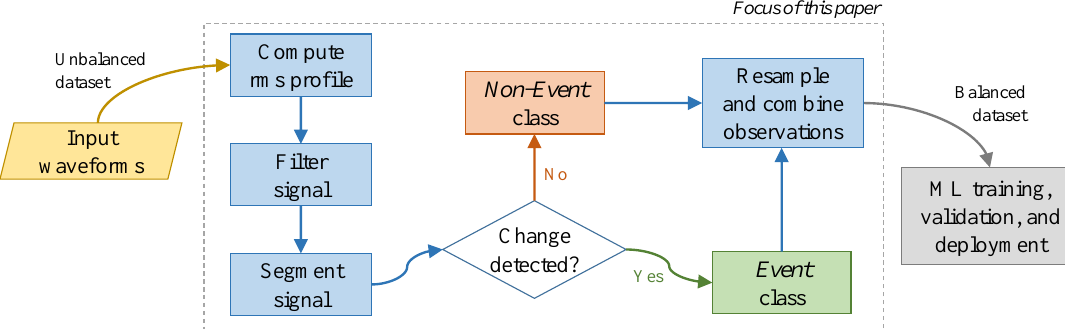
Figure 5. Overview of the power quality monitor (PQM) dataset rebalancing framework proposed in this